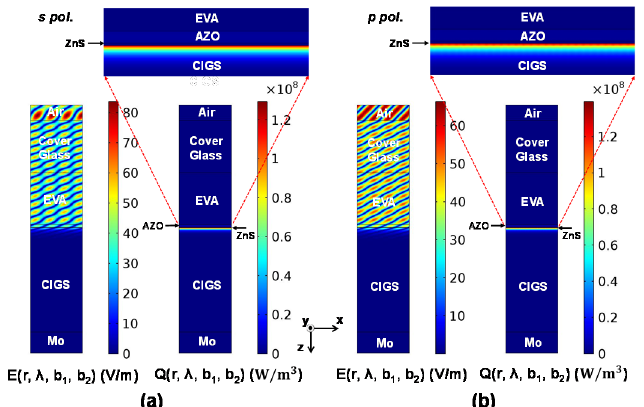
Figure 3. Spectral 2D coherent calculation results of the electric field amplitude and optical absorption at the wavelength of 400 nm when the equispaced phase thicknesses in the phase-shift layers are zero ( b 1 = b 2 = 0). The 400 nm input plane wave with the surface power density of 5.57 W/m 2 has the incidence angle of 45 ° for both (a) s and (b) polarization.